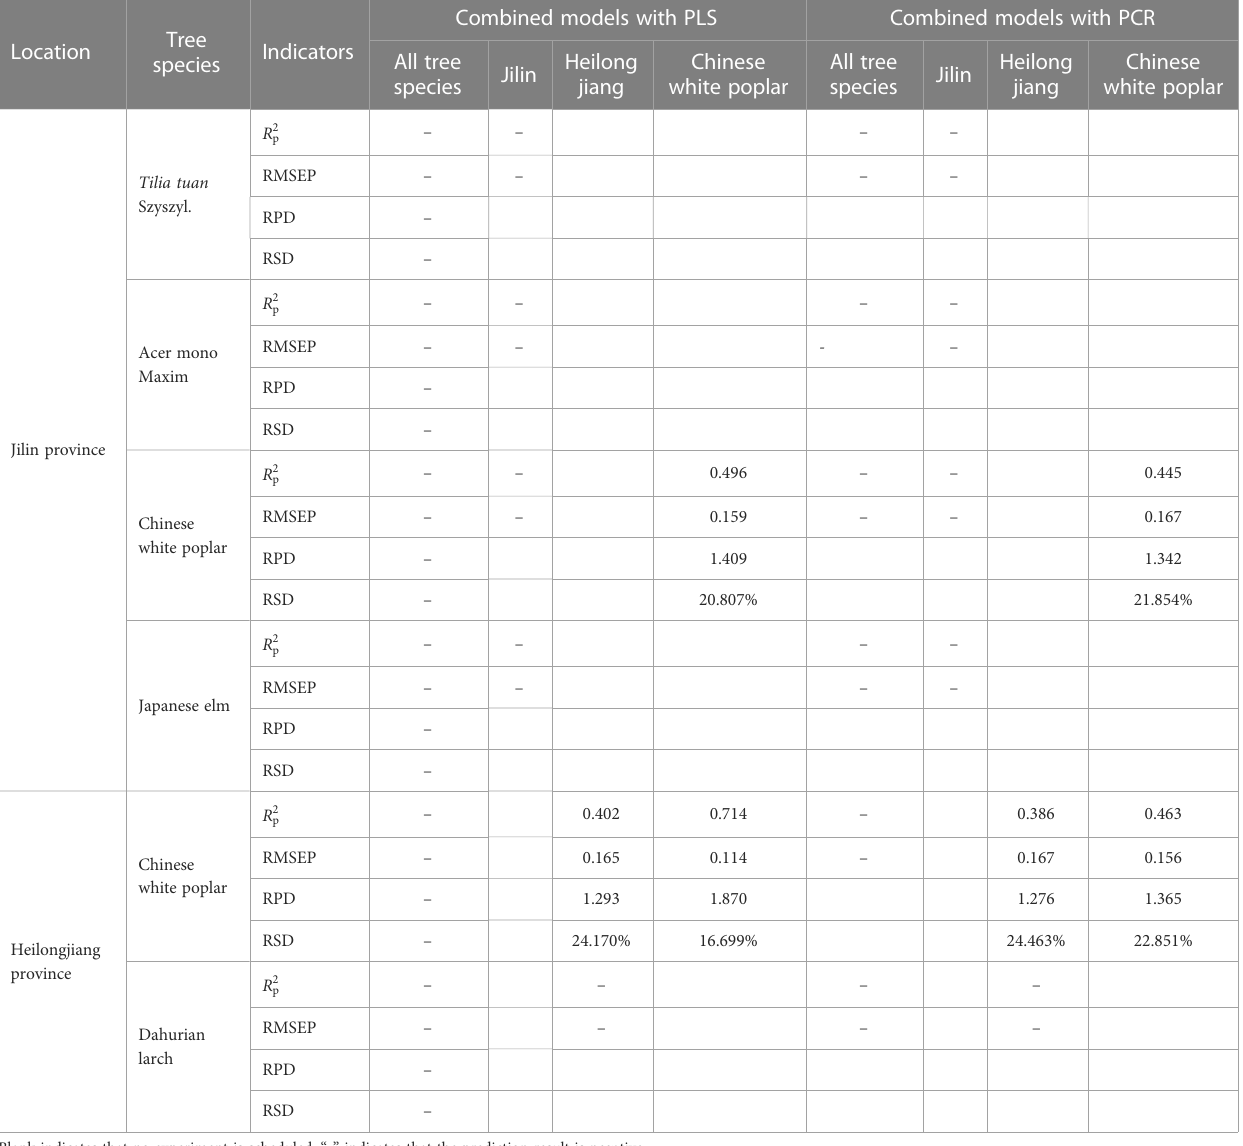
Blank indicates that no experiment is scheduled, “ - ” indicates that the prediction result is negative.